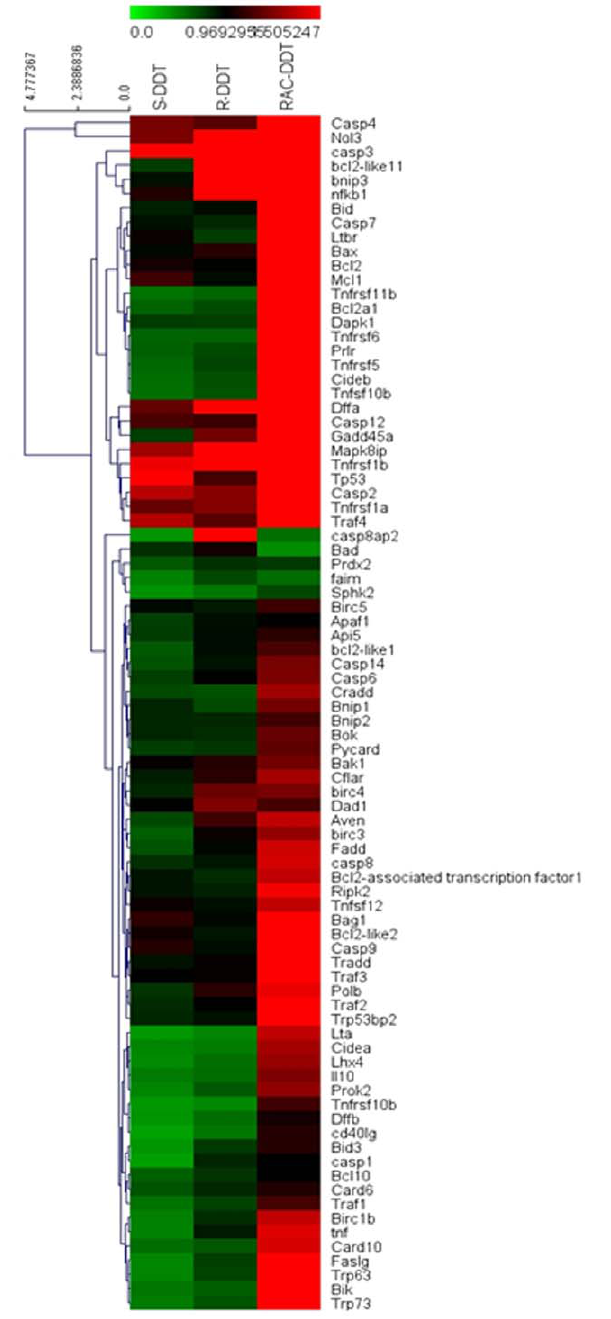
Figure 4. Heatmap of 84 apoptotic genes. The hierarchical clustering was performed for microarray data. Green indicates relative low expression, and red indicates relative high expression. doi:10.1371/journal.pone.0043823.g004 (China). Solvents for enantiomer separation were all high- performance liquid chromatography (HPLC) grade which meets ACS specifications (SK Chemicals, China).